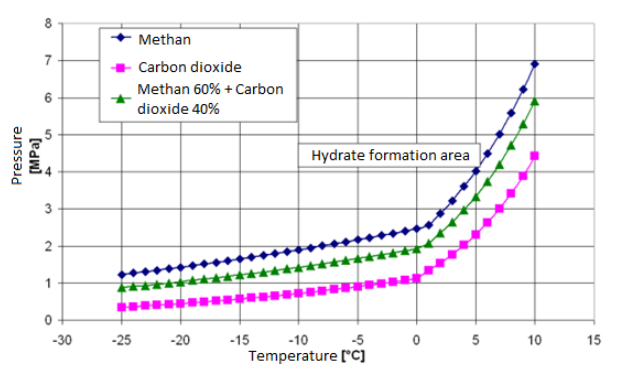
Figure 4. Diagram of methane hydrate, and their